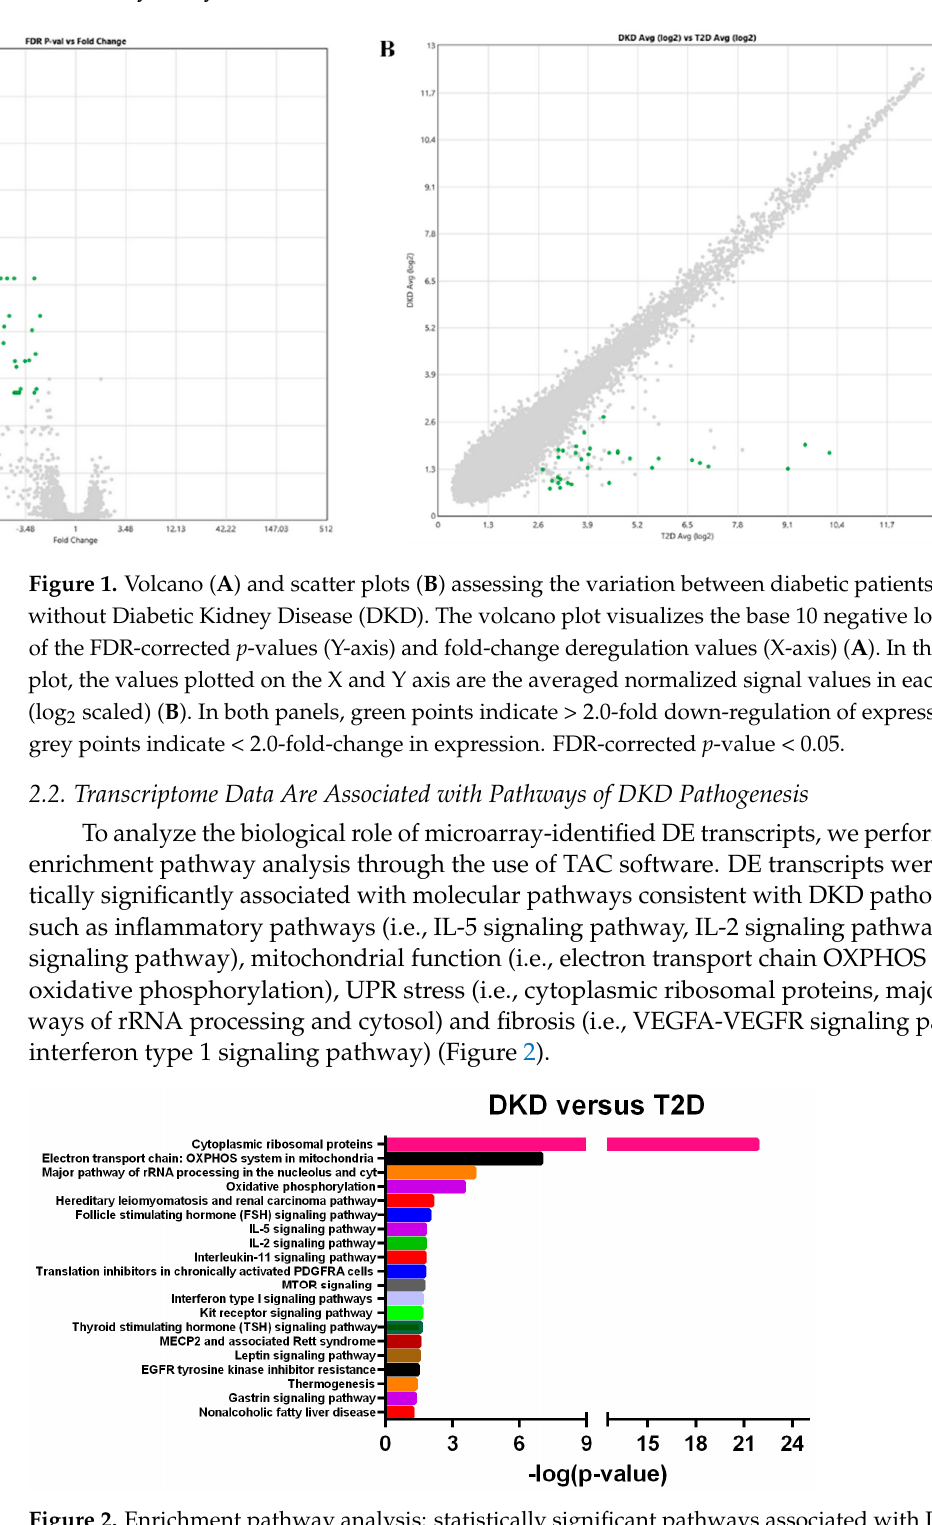
Figure 2. Enrichment pathway analysis: statistically significant pathways associated with Differen- tially Expressed (DE) transcripts in Diabetic Kidney Disease (DKD) patients versus diabetic patients without DKD (T2D). Y-axis reports the specific names of associated pathways, X-axis reports Fisher’s Exact Test values (-Log p -value ≥ 1.13).